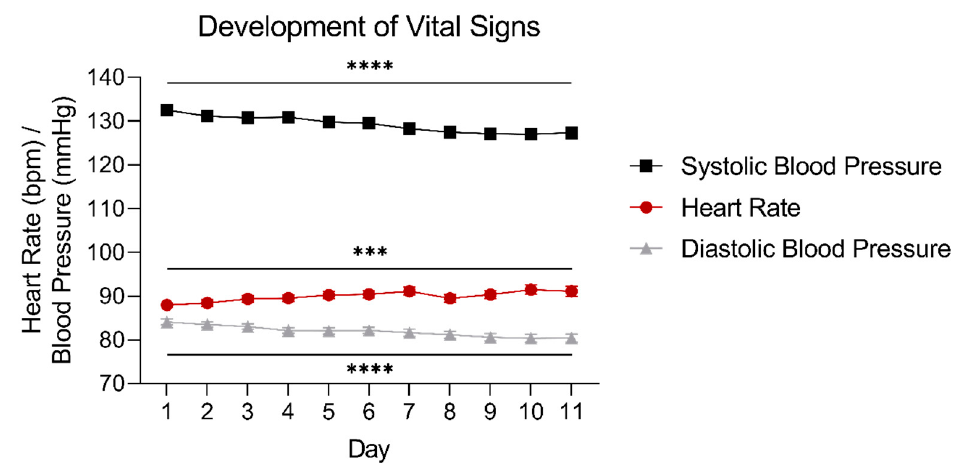
Figure 3. Development of vital signs over time during the first 11 days of GHB tapering. Data are presented as the average of all patients measured on the respective days ± SEM ( n = 108–263). Error bars may lie under the symbol of the graph. *** = main effect of time p < 0.001; **** = main effect of time p < 0.0001.